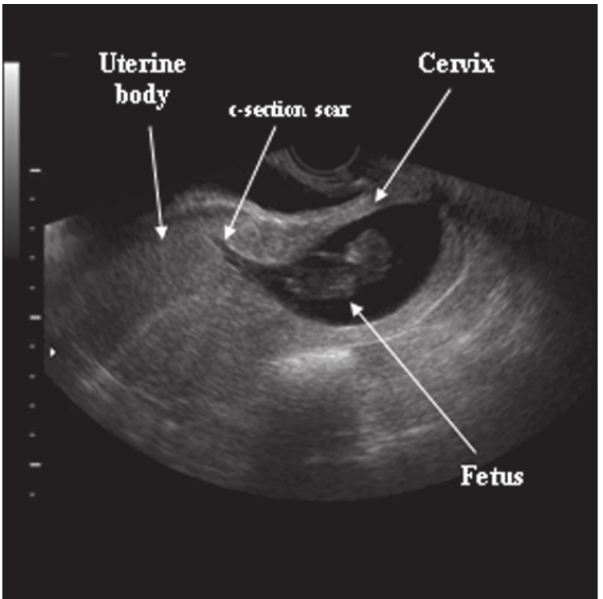
Figure 1 . Transvaginal two-dimensional ultrasonography showing a fetus without heart activity, measuring 38.0mm of crown-rump length, located in the cervical portion of the uterus (abortion or cervical pregnancy?). Note the ultrasound image of the previous cesarean-section